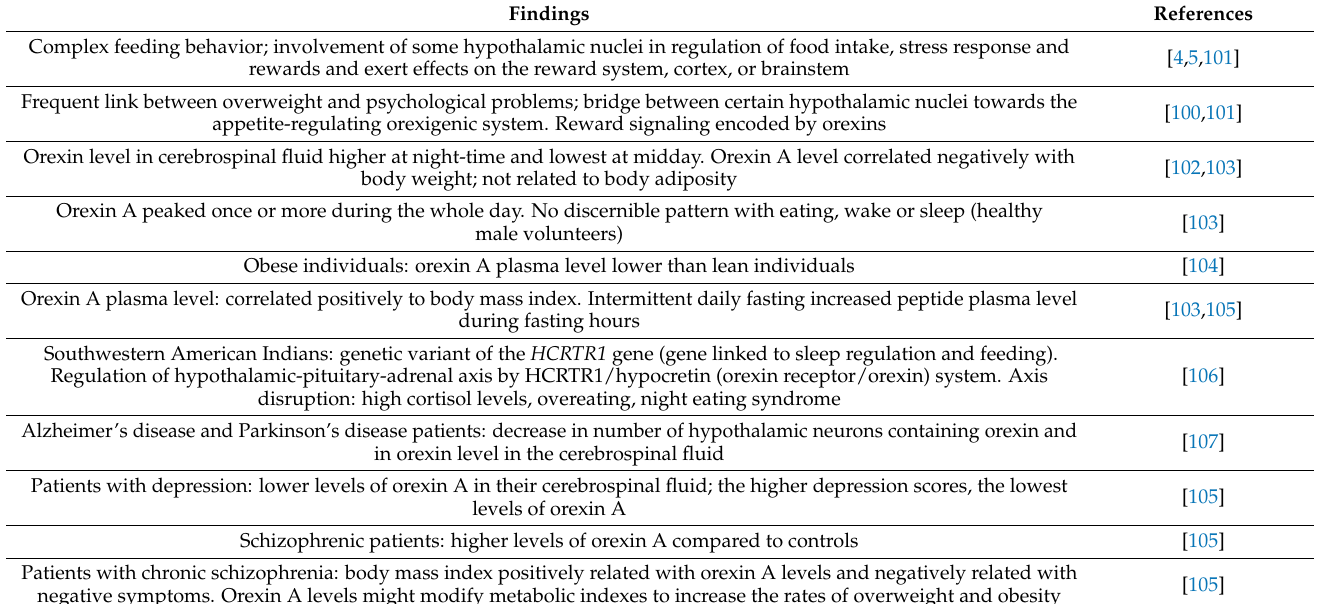
Table 4. Orexins and food intake: humans.